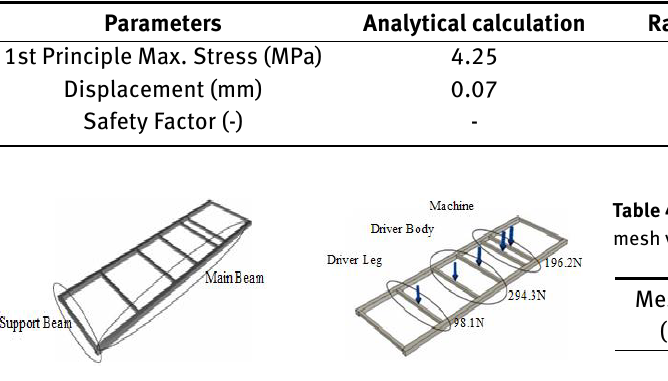
Figure 2: Shell Eco-Marathon (SEM) chassis and load distribution